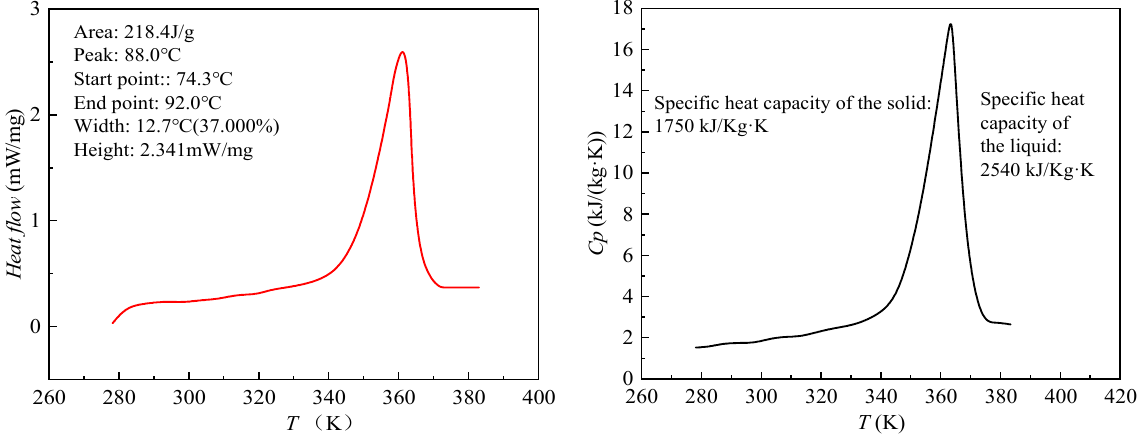
Figure 1. Differential scanning calorimeter (DSC) curves of pure paraffin. Table 1. Thermal properties of pure paraffin.